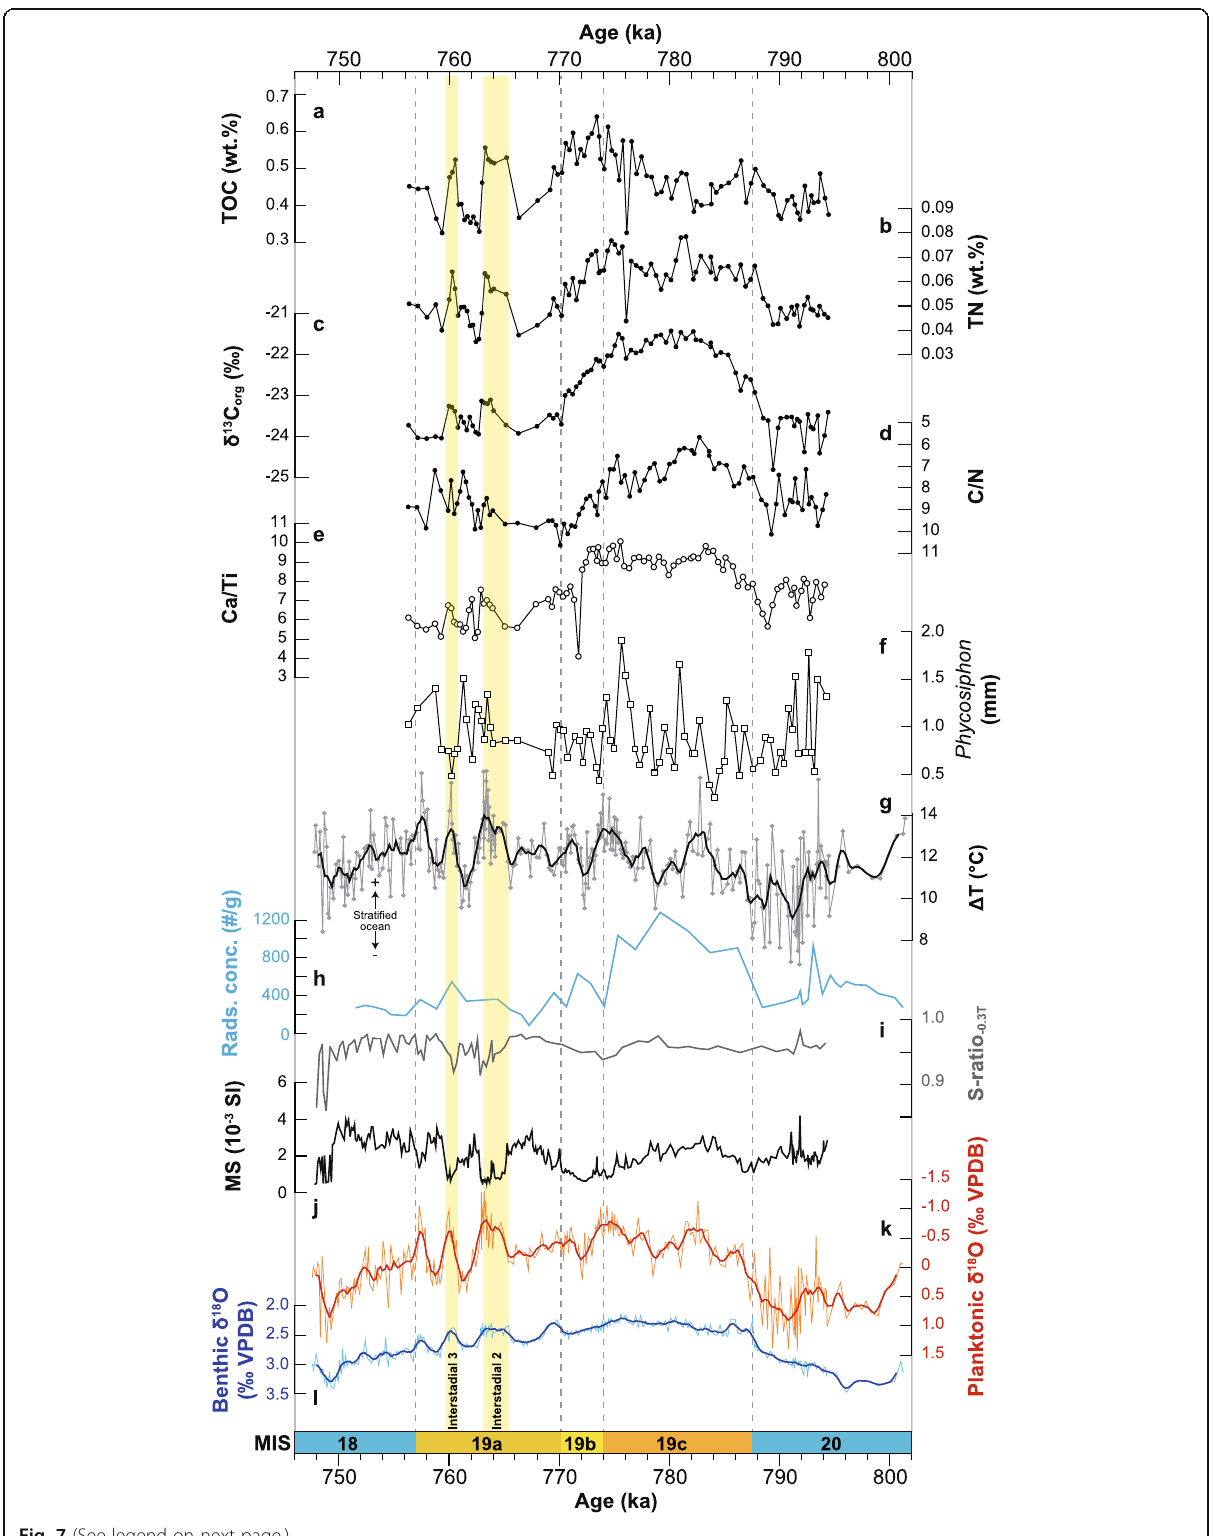
Fig. 7 (See legend on next